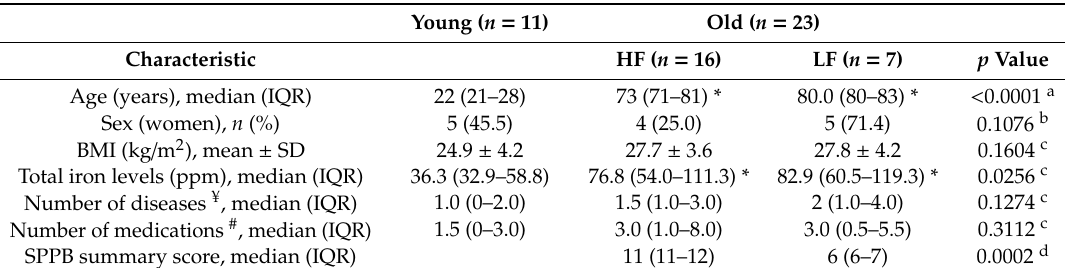
Characteristics of study participants according to age groups and physical performance